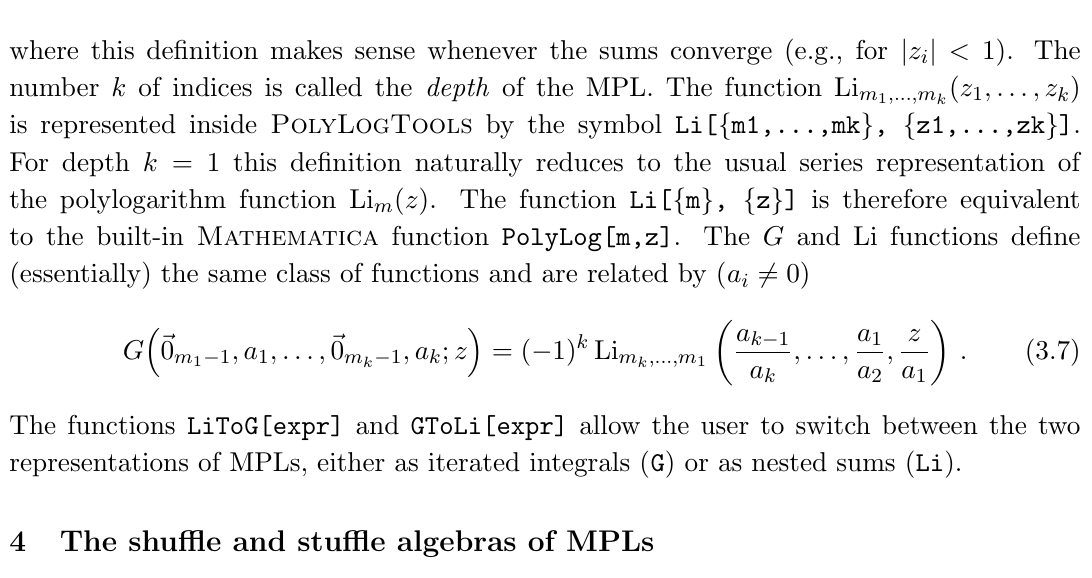
Table 1 . De(cid:12)nition of